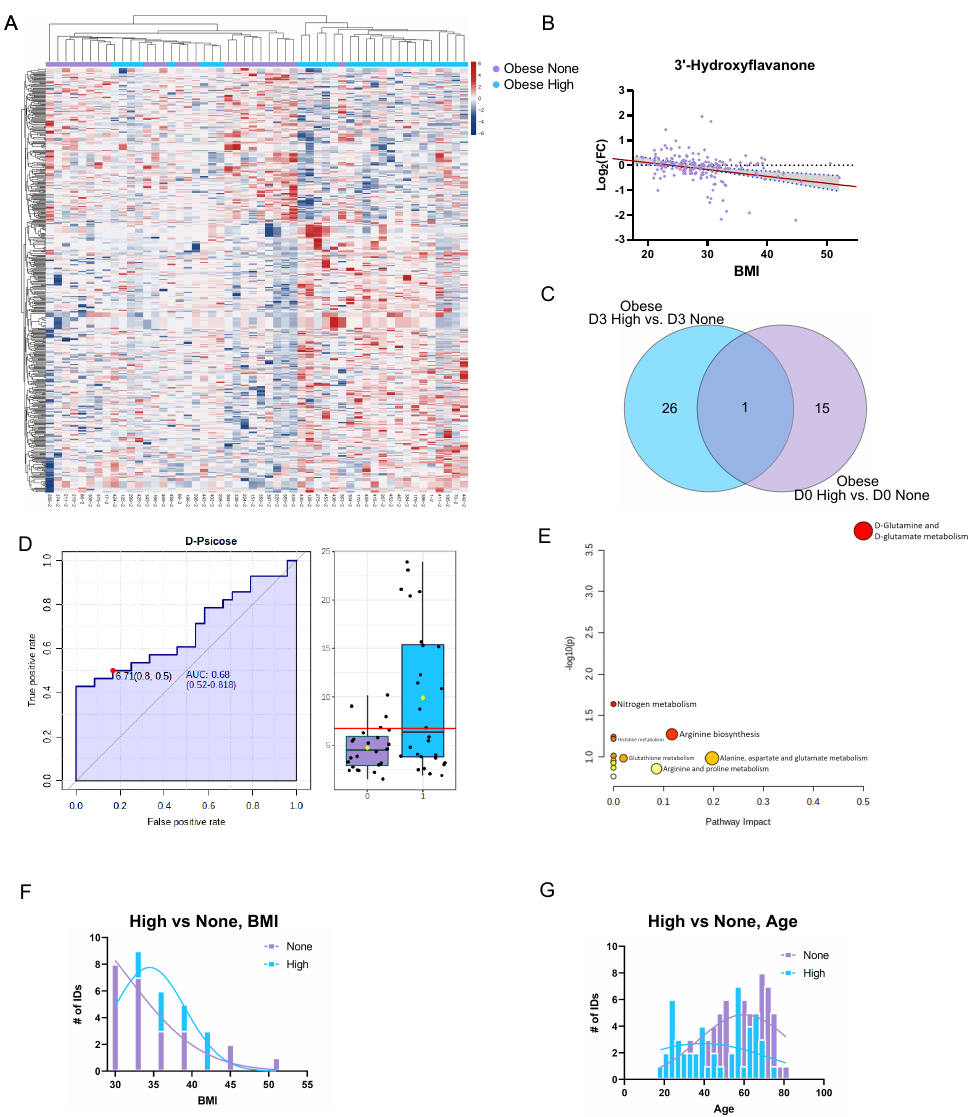
Figure 4. Differential metabolic profiles of the obese High- and None-responders. ( A ) Unsuper- vised hierarchical clustering of the metabolite profiles of the obese High-responders and obese None-responders, with n = 523 putatively identified metabolites with a raw p -value of <0.01 (t-test). ( B ) Scatter plot correlation of subject BMI with the D3/D0 change in the relative metabolite levels. The red line represents the best-fit regression, and the grey area represents the 95% confidence interval for the line of regression. ( C ) Venn diagram of overlapping significant metabolites between the obese High-responders and obese None-responders on Day 3 (D3) and also on Day 0 (D0). ( D ) Receiver operator characteristic curve (ROC curve) for the putatively identified D-Psicose metabolite discrim- inating the obese High-responders (blue) from the obese None-responders (purple). AUC = area under the curve. The red line indicates the test threshold for group discrimination. ( E ) Metabolic pathway analysis of the predictive (baseline) metabolites between the obese High-responders and obese None-responders. ( F ) BMI histogram for the High-responders and None-responders. ( G ) Age histogram for the High-responders and